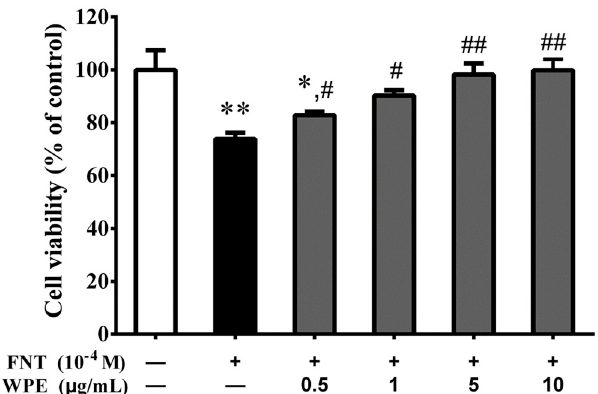
Figure 1. Effect of WPE on cytotoxicity in splenocytes exposed to FNT by MTT assay. Splenocytes were treated with fenitrothion (FNT, 10 − 4 M) or different concentrations (0.5, 1.0, 5.0 and 10.0 µ g/mL) of WPE together with FNT. Results are presented as mean ± SD of three separate experiments. * p < 0.05 or ** p < 0.01, vs. untreated control; # p < 0.05 or ## p < 0.01 vs. FNT